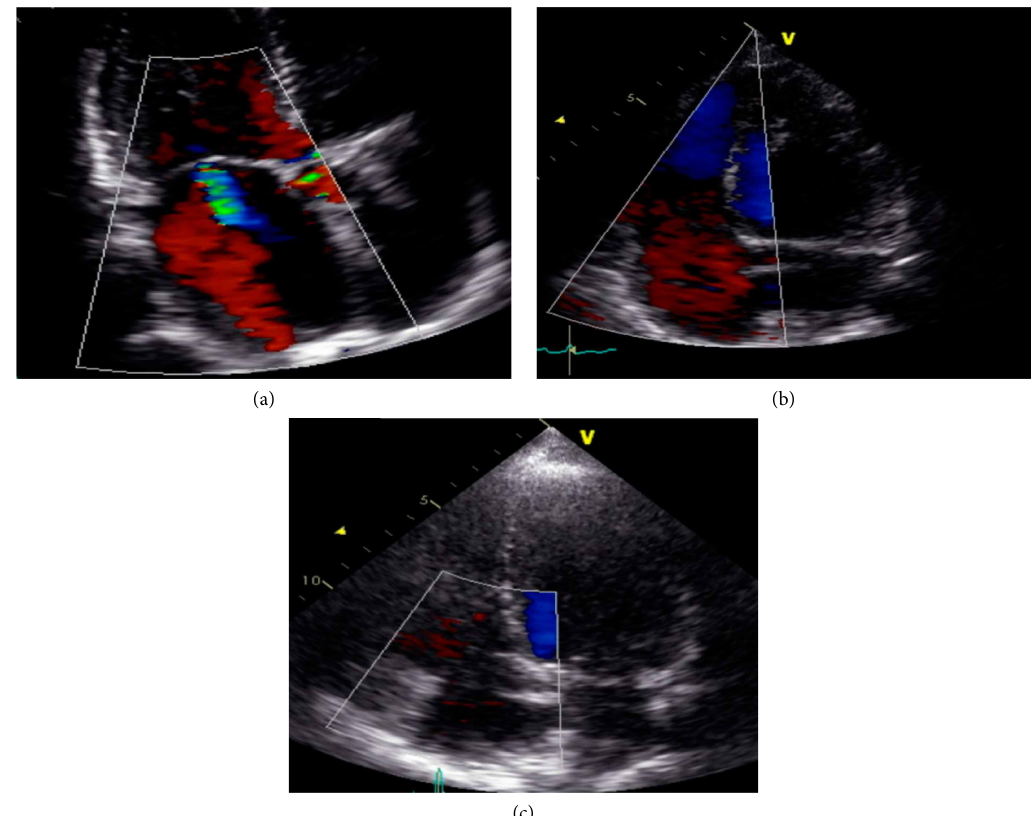
Figure 2: Echocardiography before (a), 2-days (b), and 3-months (c) after occlusion of the proximal high-flow renal arteriovenous fistula (RAVF) by Amplatzer Vascular Plug (AVP) Device II placement into the left renal artery (LRA). (a) 4-Chamber view with Doppler ultrasound found a functional (secondary) tricuspid regurgitation (Grade I). Recognize the enlargement of the right atrium due to increased volume load. (b and c) 4-Chamber view with Doppler ultrasound found no tricuspid regurgitation 2-days and 3 months after RAVF occlusion. Also recognize normalization of the right atrium dimensions due to reduced volume